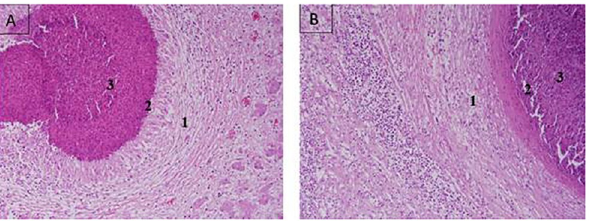
Fig 2. Histologic section of liver and lymph node of dromedary camel infected with CLA. (A) Liver section showing central caseous necrotic core admixed bacterial colonies and infiltration of polymorphonuclear cells, lymphocytes, plasma cells and macrophages (3), surrounded by pyogenic membrane (2), and fibrous capsule (1), H&E stain, 20 × . (B) Lymph node section showing central caseous necrotic abscess (3), surrounded by inflammatory cells (2) and bound by a thick fibrous capsule (1), H&E stain 20 ×